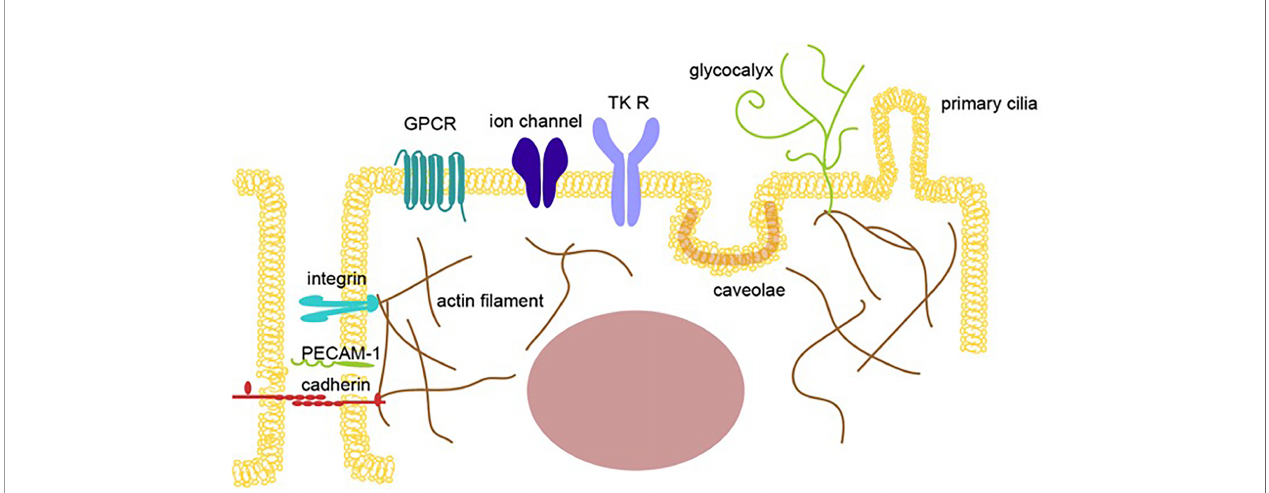
FIGURE 1 | Mechano-sensing receptors in endothelial cells. An illustration showing multiple mechano-sensing receptors, including mechanosensory ion channels and adhesion molecules, that can respond to extracellular stimulations, such as pressure, gravity, acceleration, sound, tension, fl uid fl ow, pain, light, temperature, and blood pressure, to induce mechanotransduction in endothelial cells. The sensors shown include tyrosine kinase receptors (TK R), G protein-coupled receptors, ion channels, junction proteins, integrins, the cell membrane (caveolae), and